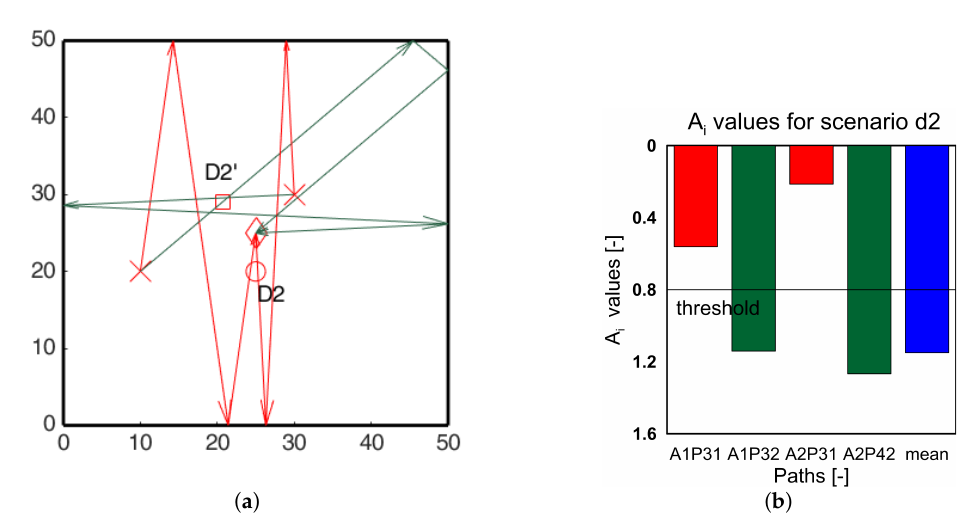
Figure 13. ( a ) Edge reflection paths passing through the identified hotspots; ( b ) A i ratio edge reflection paths passing through the identified hotspots for scenario D2.